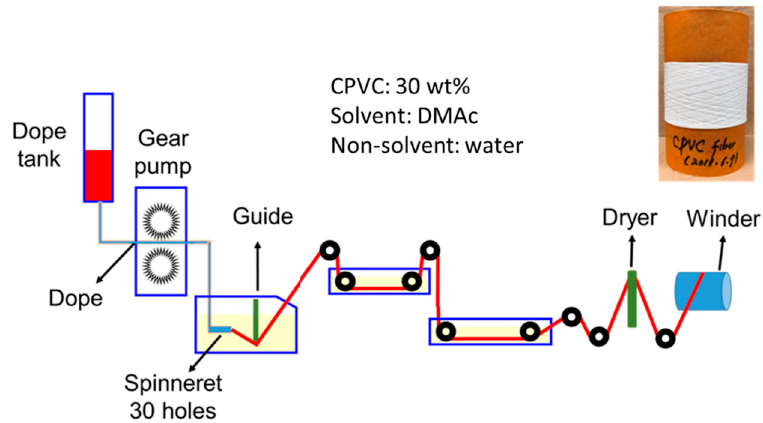
Figure 1. A schematic diagram of the self-designed apparatus for the solution spinning of highly chlorinated polyvinyl chloride